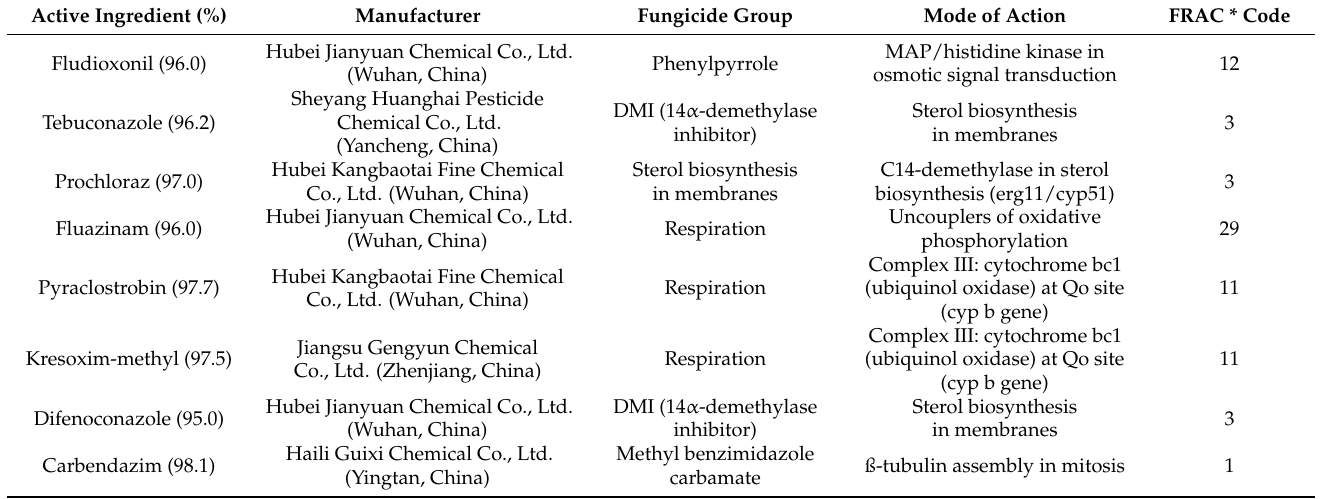
Table 1. Fungicides used in this